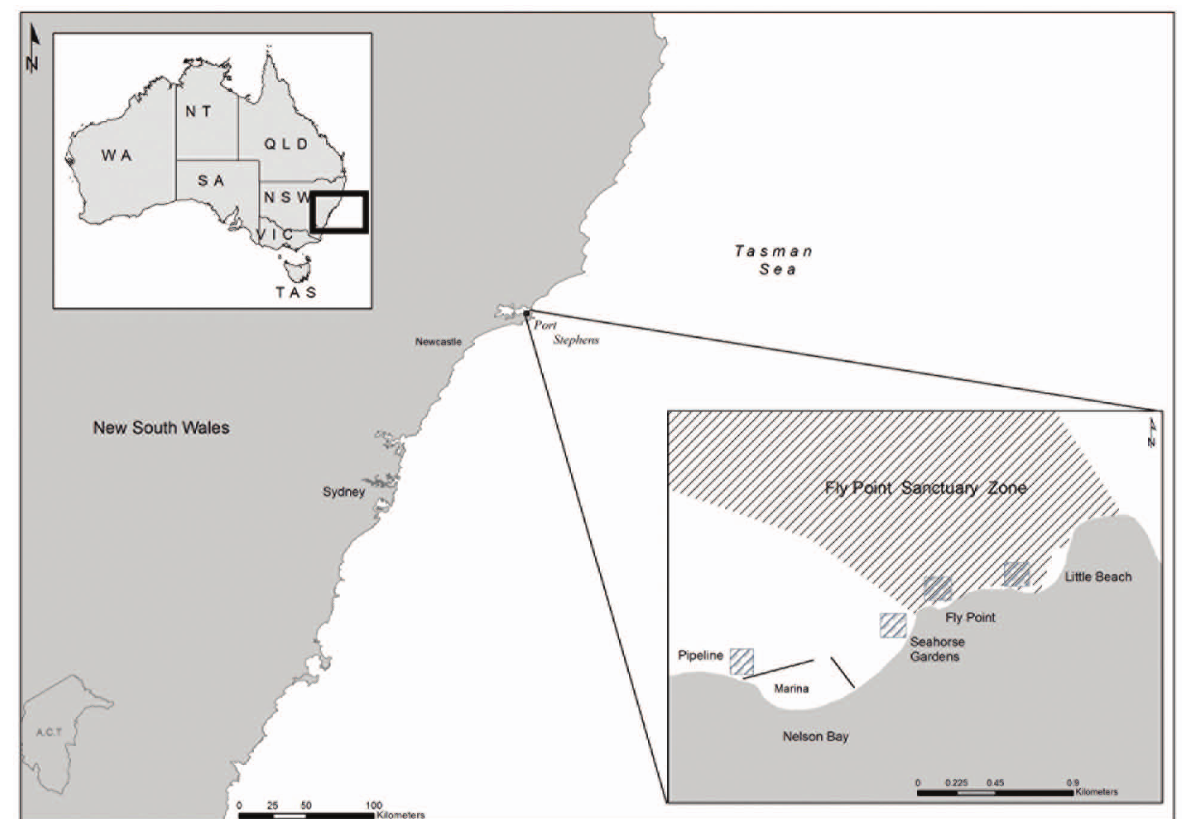
Figure 1. Location of study sites, Port Stephens, New South Wales – Australia.